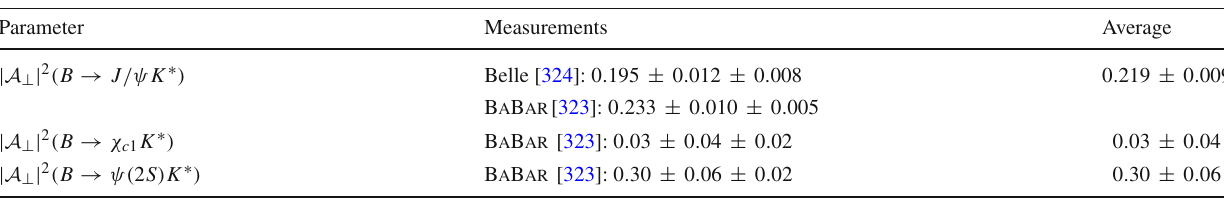
Table 181 Decay amplitudes for perpendicular transverse polarization